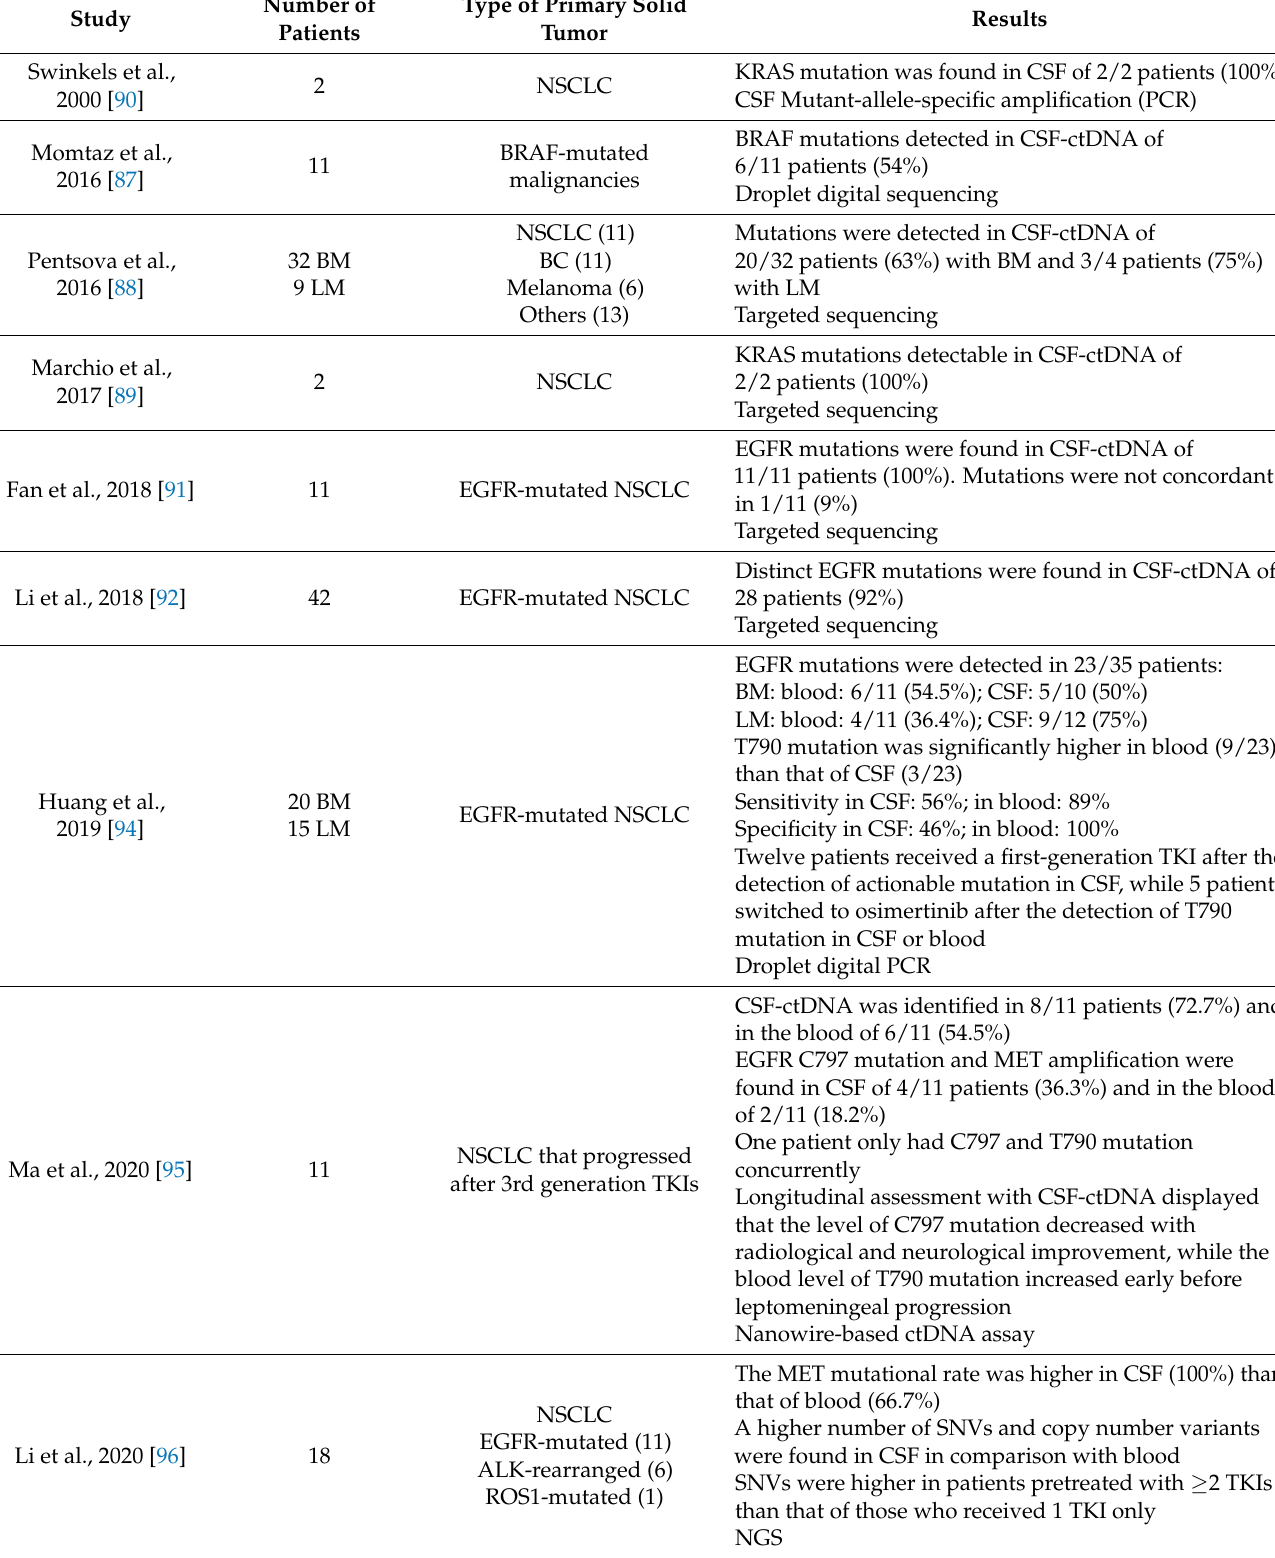
Table 3. Studies on circulating tumor DNA in CSF from